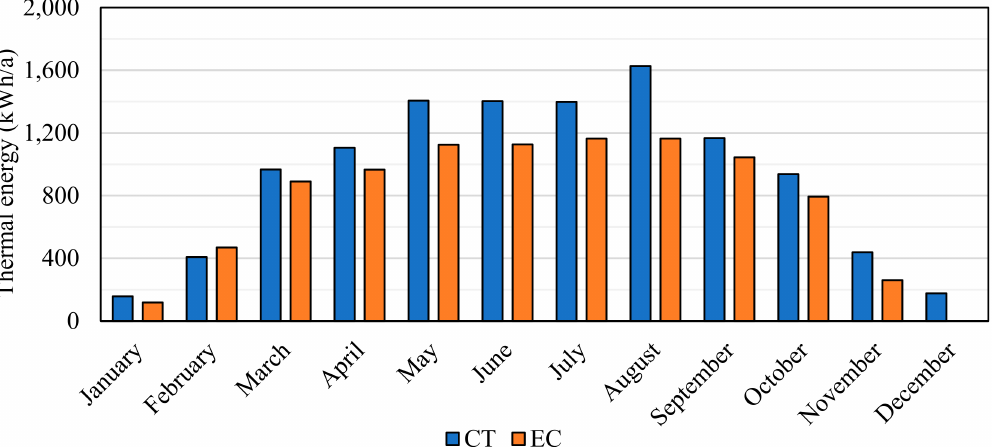
Figure 15. A comparison of the thermal energy delivered by solar collectors to the storage tank. In Figure 16, a comparison between the annual heat losses of each subsystem is shown. Differences between the heat losses in the space heating emission subsystem (45%) can be mainly attributed to different methods for determining heat losses (method of indoor air temperature increase vs. efficiency method) and to the differences in obtained recovered heat losses of the overall system. The comparison shows that the monthly time step yields higher SH distribution subsystem heat losses, relative to the more detailed hourly time step (13%). Differences of 34% were also found in the obtained storage tank heat losses. Significant differences in the obtained heat losses were found in the DHW distribution subsystem (32%).